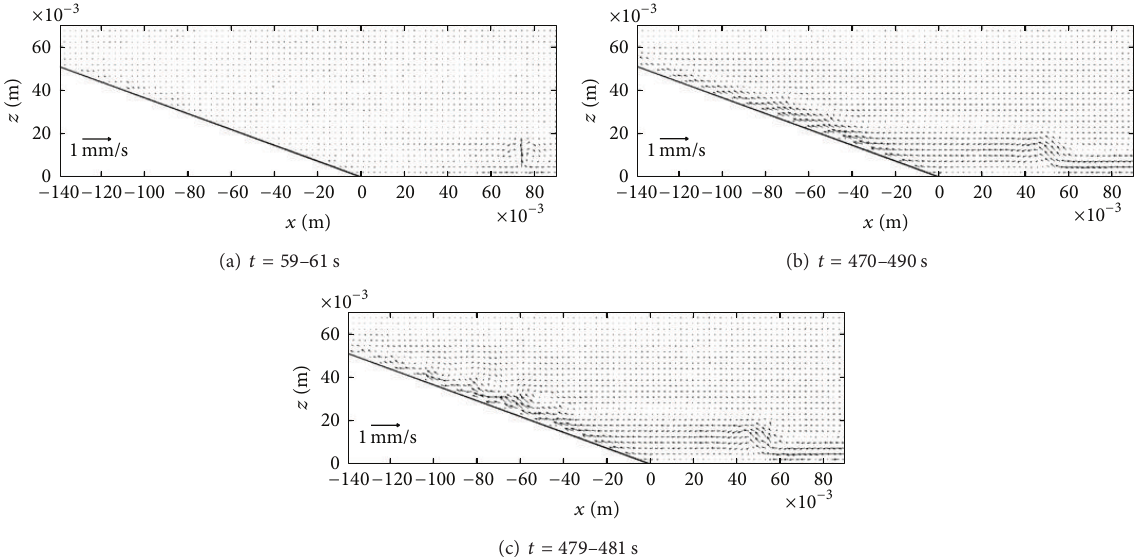
Figure 37: Mean velocity fields after (a) 60 s (average over 2 s), (b) 480 s (average over 20s), and (c) 480 s (average over 2 s) from the beginning of case C3.